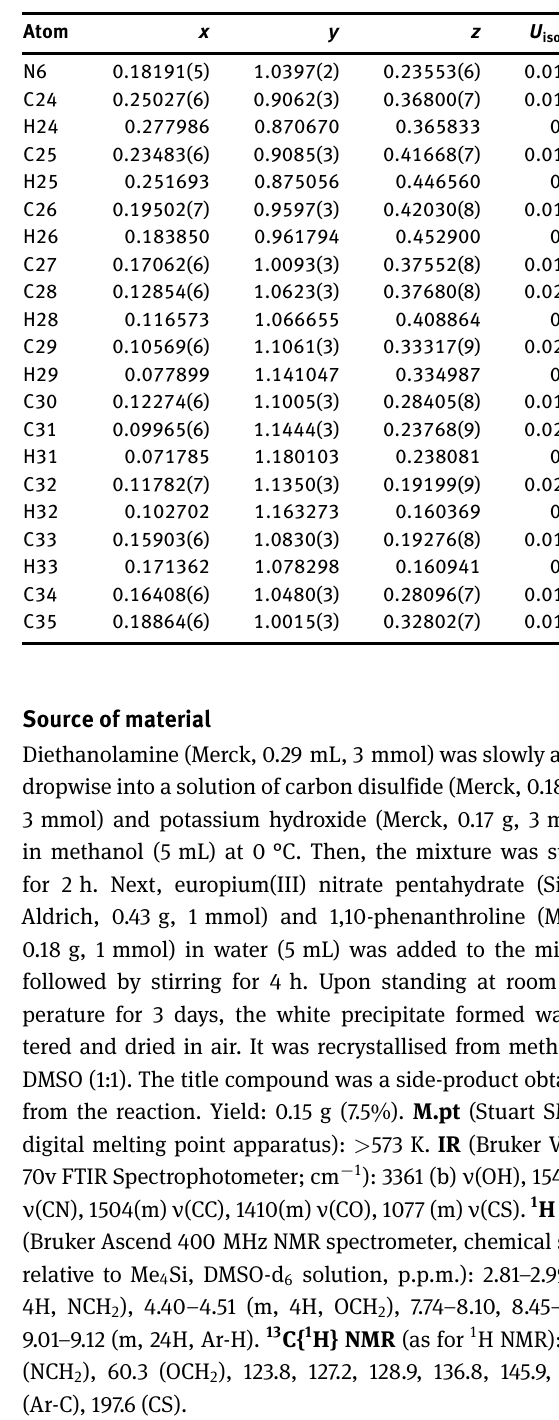
Table 2: Fractional atomic coordinates and isotropic or equivalent isotropic displacement parameters (Å 2